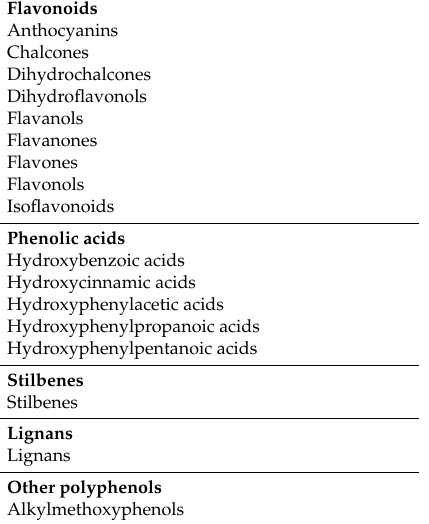
Table A1. Polyphenol classes and sub-classes based on Phenol Explorer